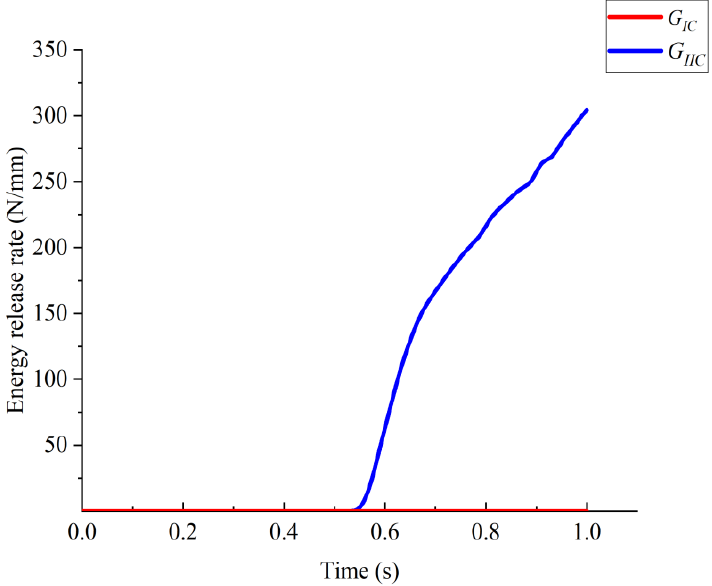
Figure 8. Energy release rate versus time for model II delamination failure.